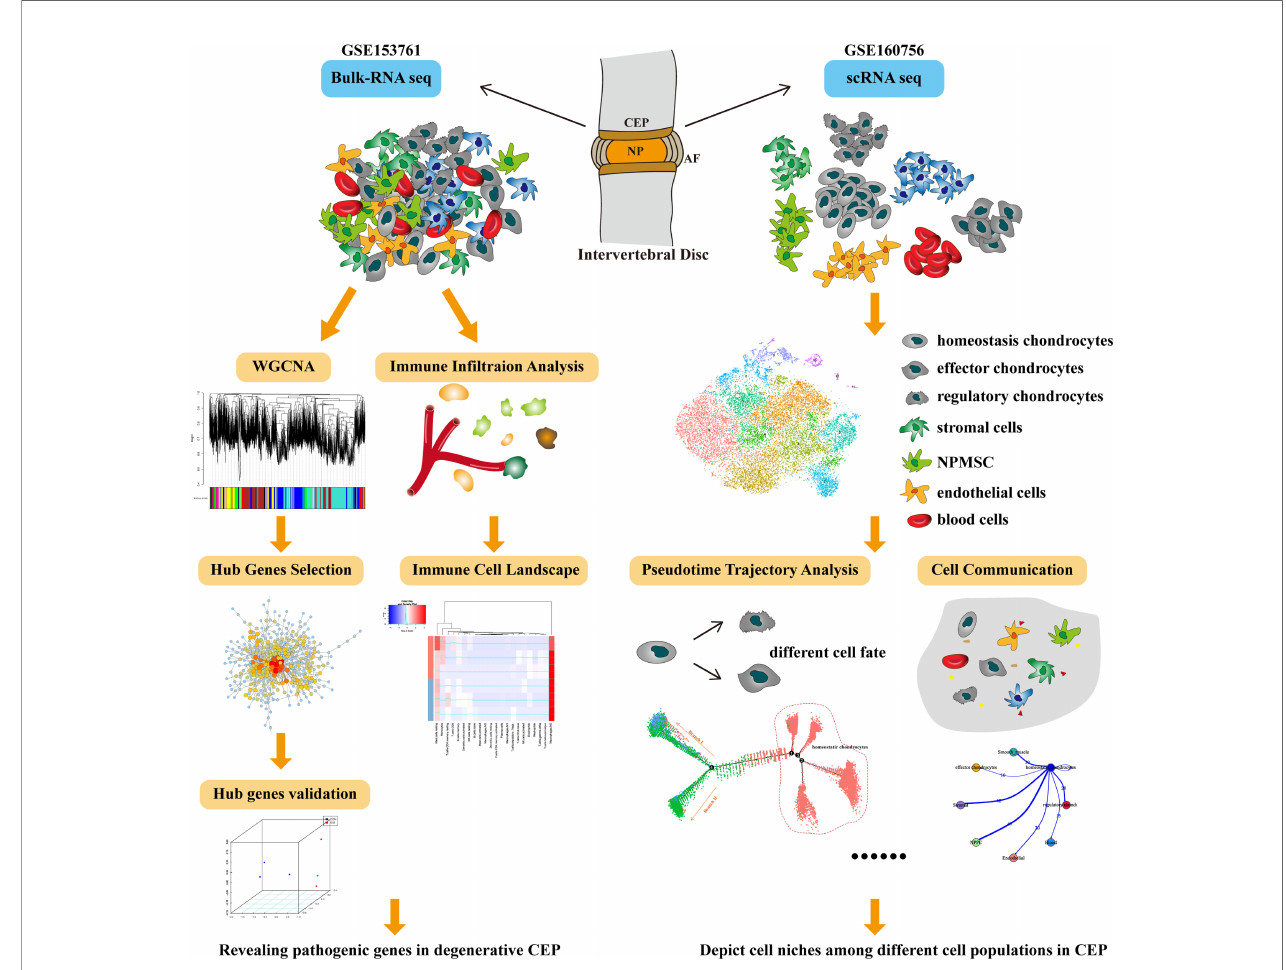
FIGURE 1 | The whole diagram and work fl ow of this